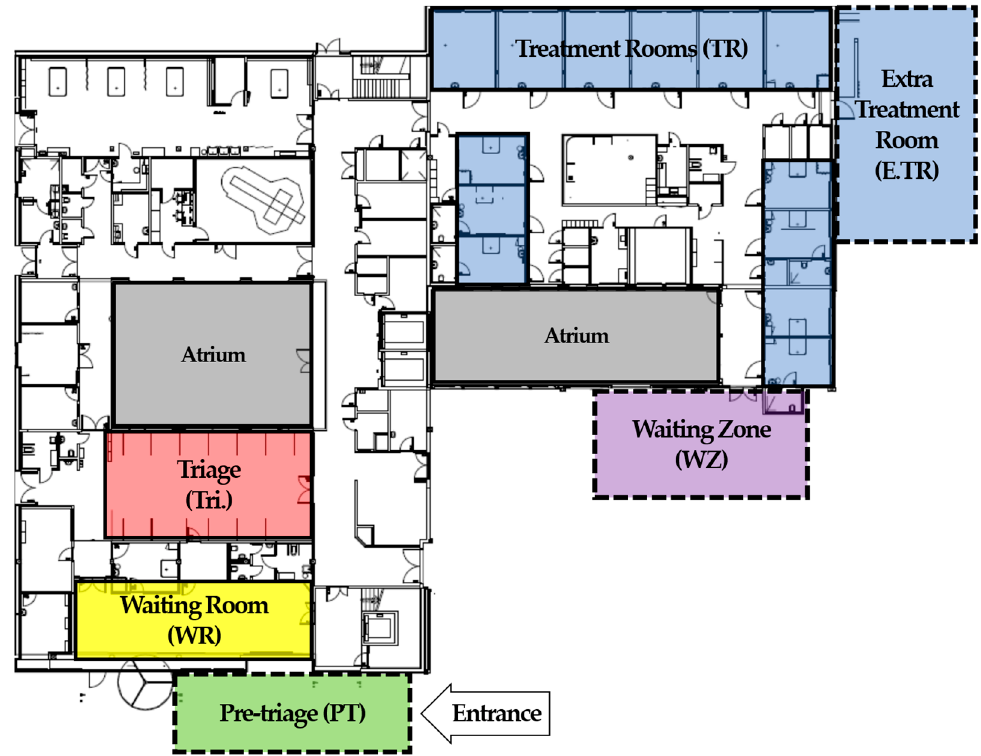
Figure 5. Case ED layout with the new pandemic introduced resources inside dotted lines. Waiting room (WR) in yellow, treatment rooms (TR) and extra treatment rooms (E.TR) in blue, pre-triage (PT) in green and waiting zone (WZ) in purple.